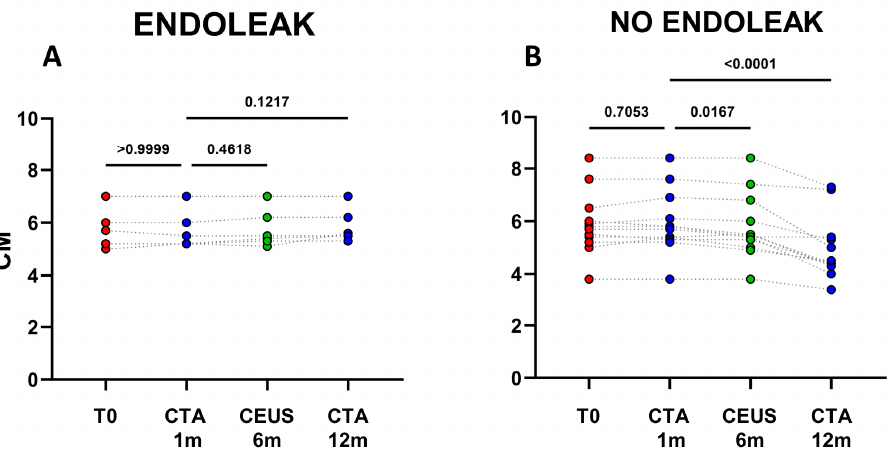
Figure 2. Dots represent size (cm) of aneurysms in patients developing endoleaks ( n = 6) ( A ), and in patients who did not develop endoleaks ( n = 12) ( B ). Patients were analyzed at baseline (T0) and after 1, 6, and 12 months following EVAR intervention, as established in the clinical